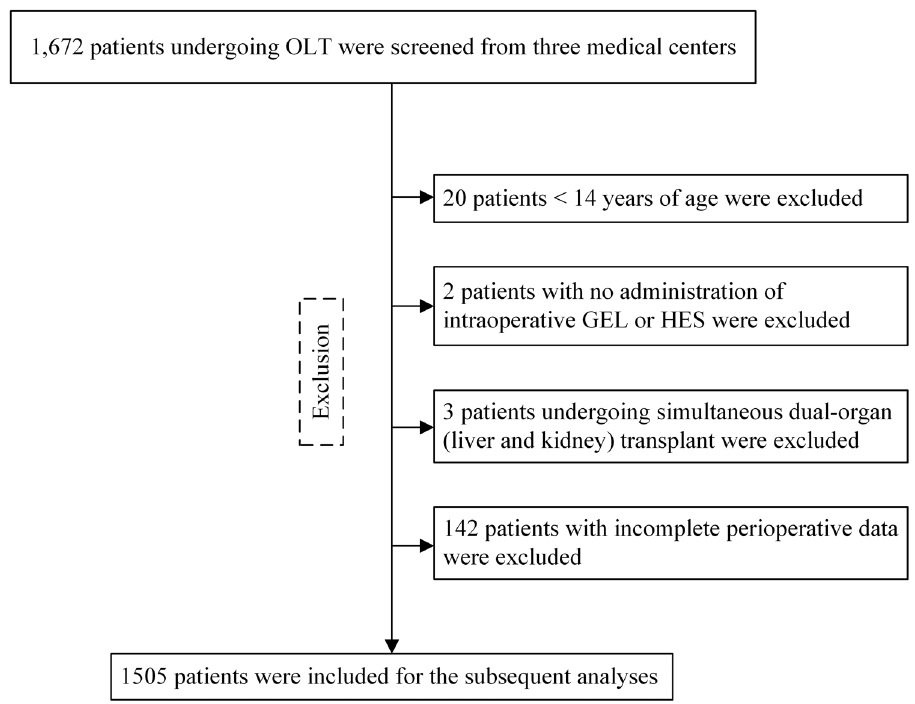
Figure 1: Enrollment fl